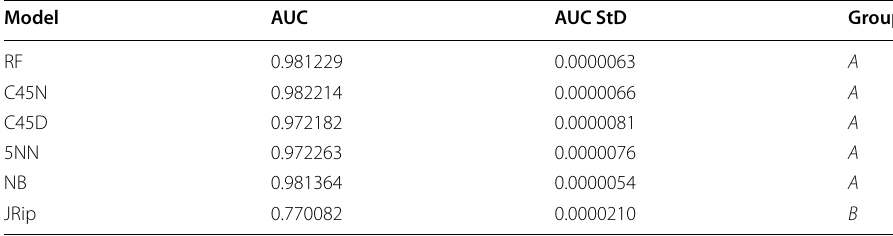
Table 13 Tukey’s PCA